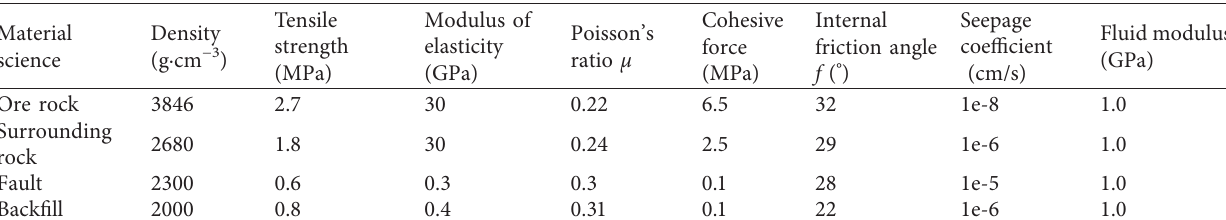
Table 1: Parameters for different rocks mass.